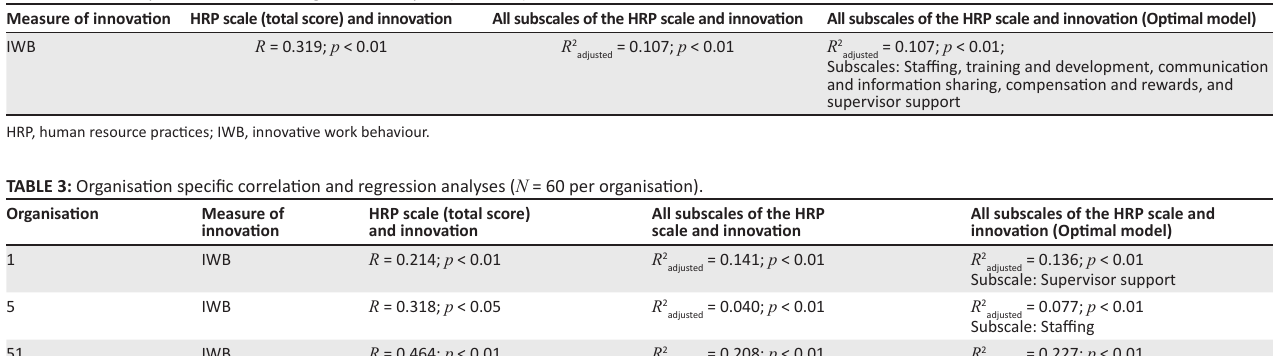
TABLE 2: Total sample correlation and regression analyses ( N = 3180). Measure of innovation HRP scale (total score) and innovation All subscales of the HRP scale and innovation All subscales of the HRP scale and innovation (Optimal model) IWB R = 0.319; p < 0.01 R 2